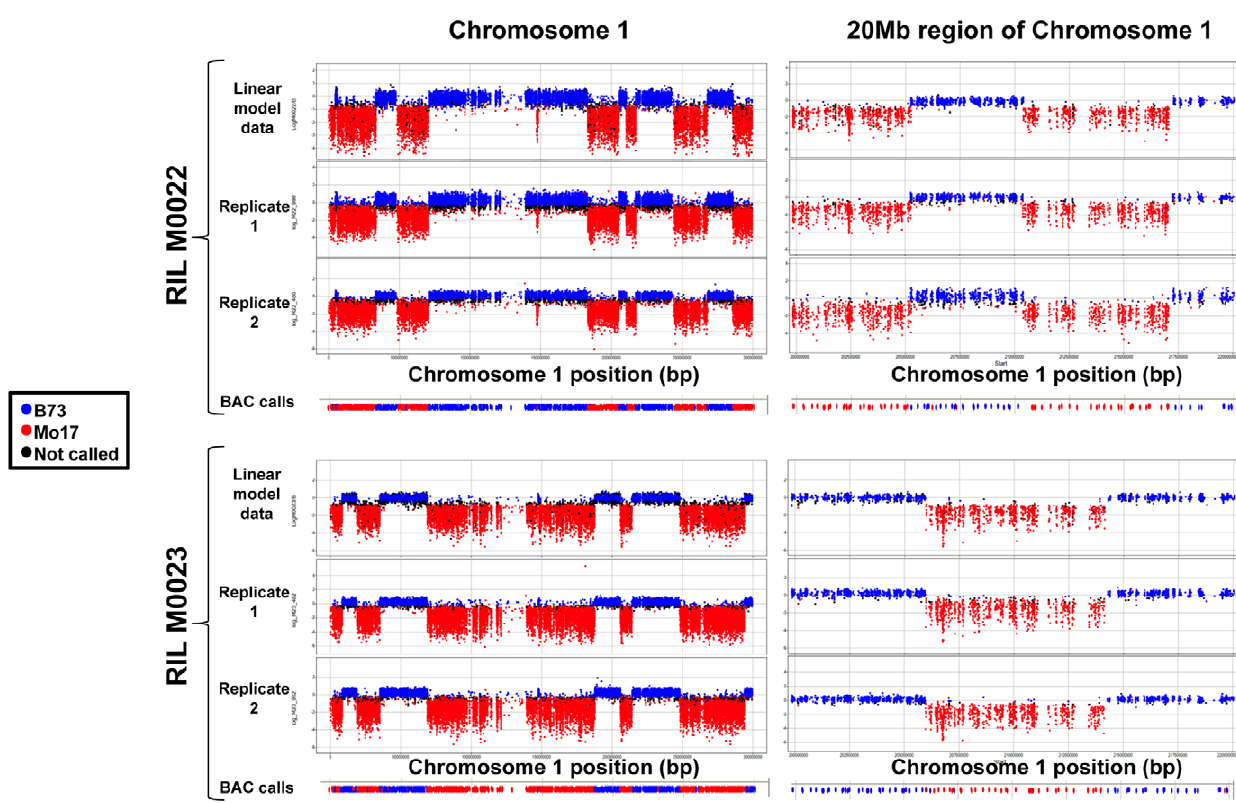
Figure 1. Comparisons of analytical approaches for CGH-based mapping. Data for B . M probes located on chromosome 1 that exhibit at least a 2-fold change (n=26,953) were plotted following the use of different data analysis approaches. The upper set of plots display data for the RIL M0022 while the lower panels show data for the RIL M0023. The plots on the left and right display probes from the entire chromosome 1 and a close- up view of a 20 Mb region of chromosome 1 (positions 200 Mb–220 MB), respectively. For each set of plots the first panel provides visualization genotyping calls and log2 (RIL/B73) ratios following normalization and analysis using a linear model of multiple replications (Method I). The second and third panels show the genotyping calls and log 2 (RIL/B73) ratios based on the analysis of a single replicate of data that was normalized using standard NimbleScan approaches (Method II). The final plot shows the genotyping calls for each BAC (n=1,369) using data from replicate 1 (Method